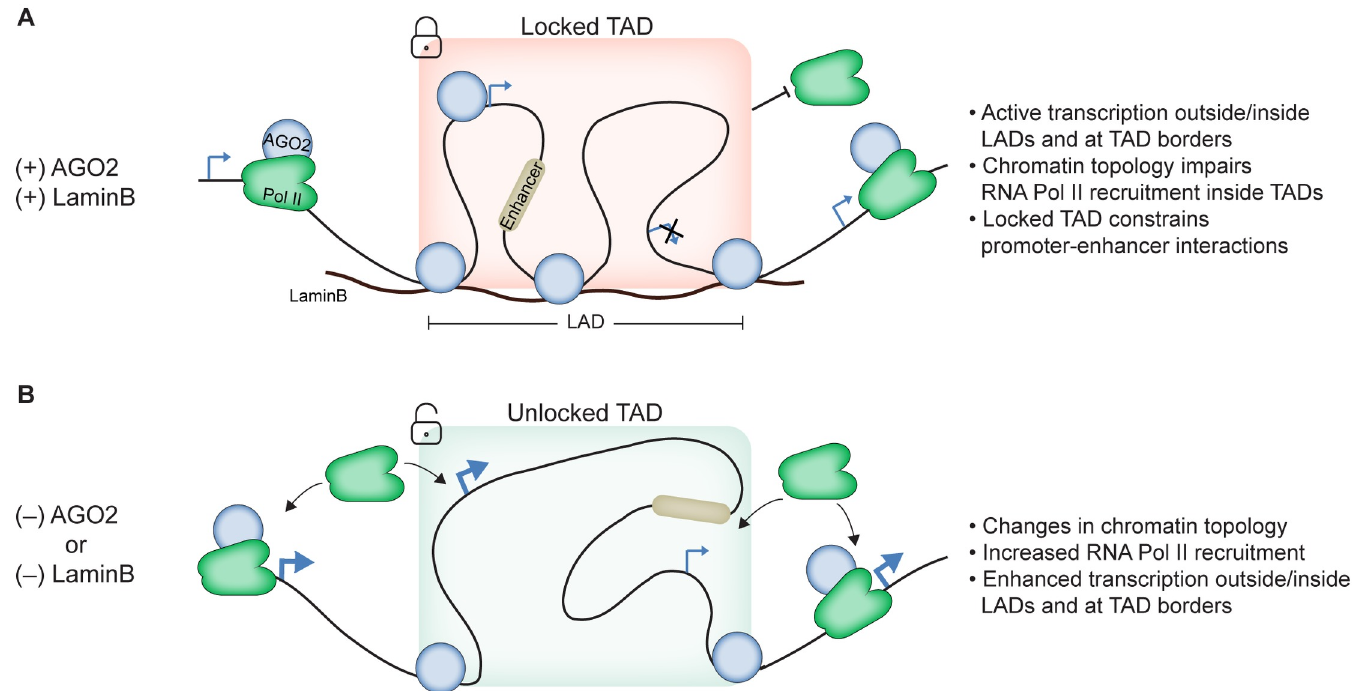
Fig 6. A model for enhanced transcription upon depletion of LaminB or AGO2. A) AGO2 associates with genes both outside and inside the LAD/TAD. LaminB scaffolding helps maintain the TAD in a locked structure, likely impairing Pol II recruitment and preventing promoter-enhancer interactions across the TAD border. B) Upon depletion of either AGO2 or LaminB the chromatin topology from the LAD/TAD switches from a locked to a more accessible unlocked structure, thus permitting inter-TAD interactions. As a result, Pol II recruitment and promoter-enhancer interaction may be